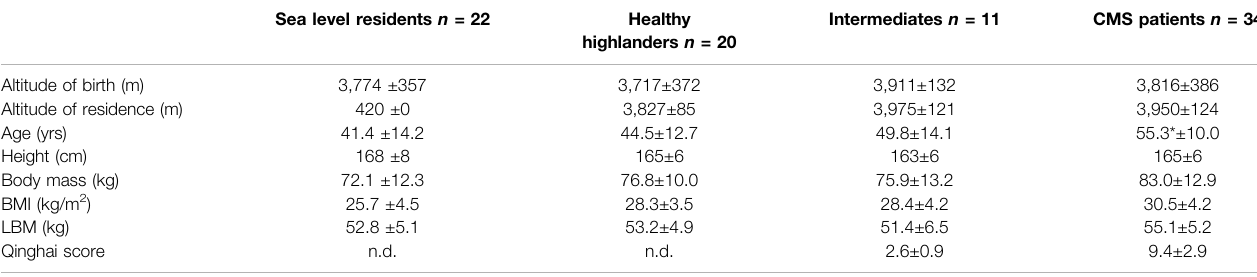
Sea level residents n = 22 Healthy